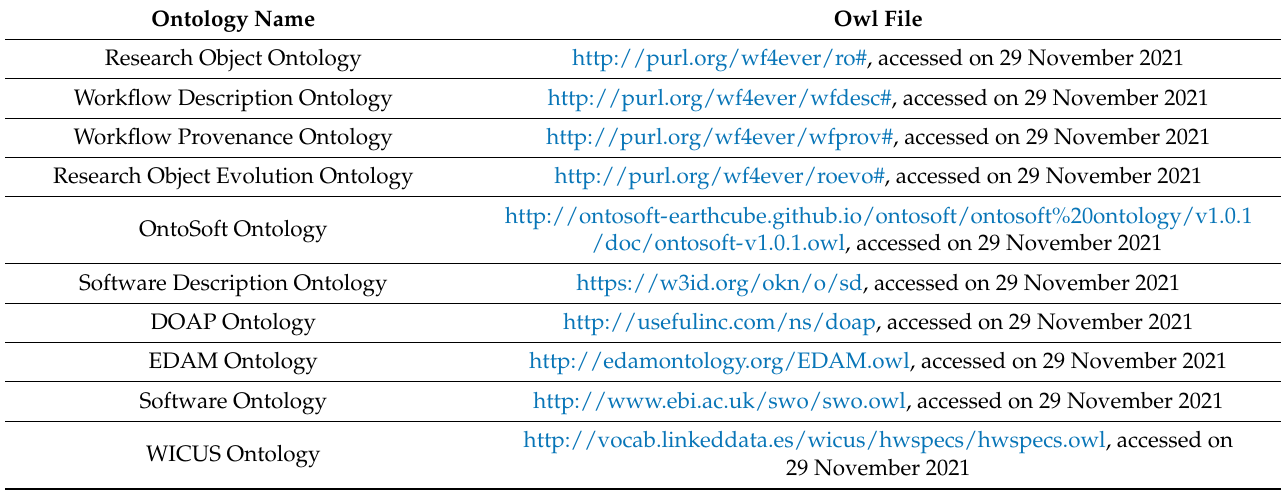
Table 1. Ontologies that can provide semantic annotation for computational